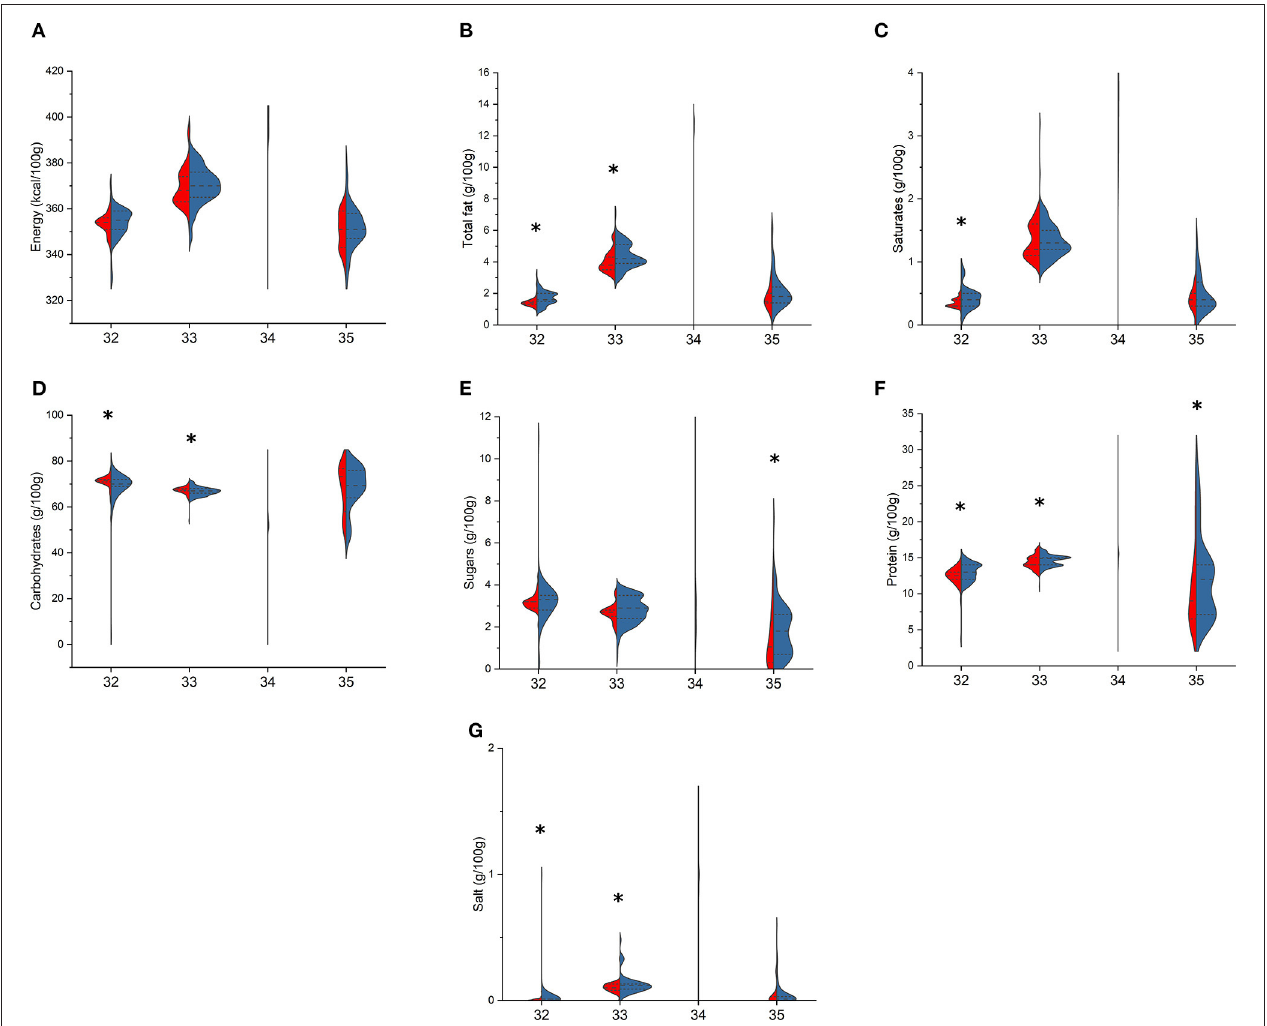
FIGURE 7 | Comparison of energy (A) , total fat (B) , saturates (C) , total carbohydrates (D) , sugars (E) , protein (F) and salt (G) content in branded (BR, in blue) and private-label (PL, in red) types of dried pasta. 32: semolina pasta; 33: egg pasta; 34: stuffed pasta; 35: special pasta. For each type, asterisk indicates significant difference between BR and PL items (Mann–Whitney non-parametric test for two independent samples), p <